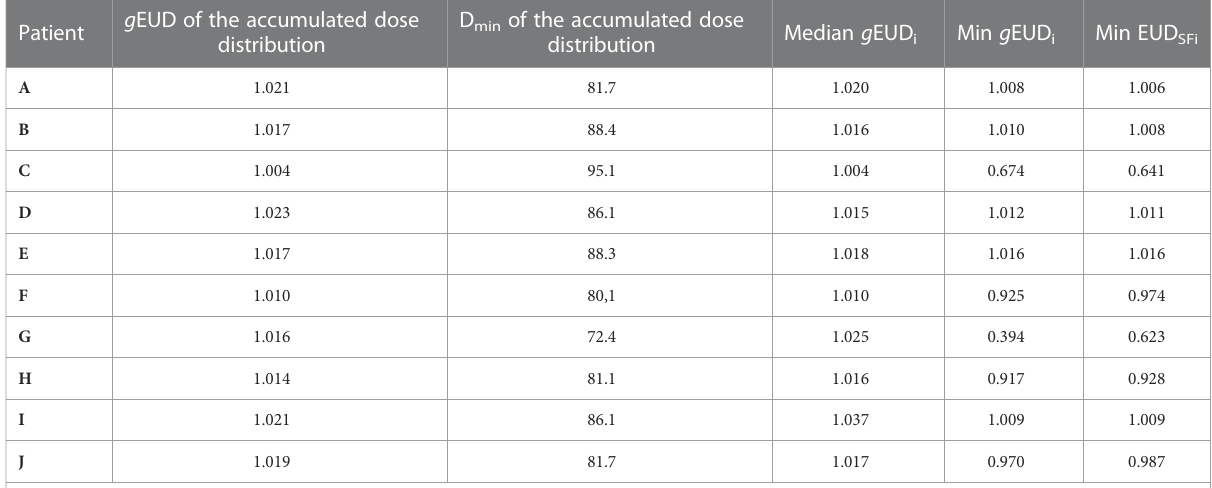
Depiction of gEUD of the accumulated dose distribution, D min of the accumulated dose distribution, median and min gEUD i , for the different fractions i of the treatment series, min EUD SFi , for the clinical plans. All EUDs are normalized to the prescribed doses. EUD SF was calculated for a treatment series of30 fractions at 2Gy per fraction, repeatedly applying the dose distribution of the considered fraction.